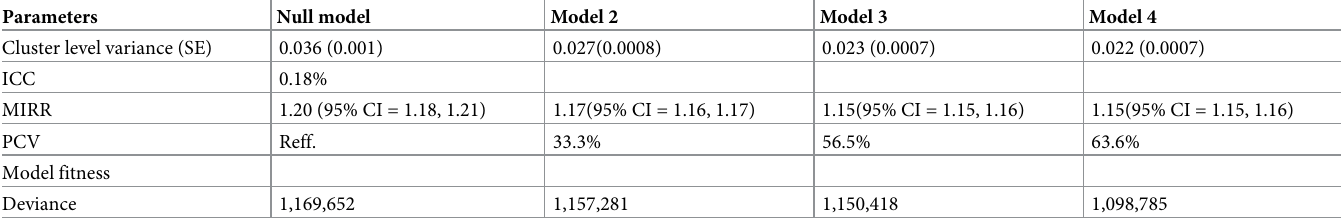
Table 2. Parameters and model fitness statistics for multilevel negative binomial regression